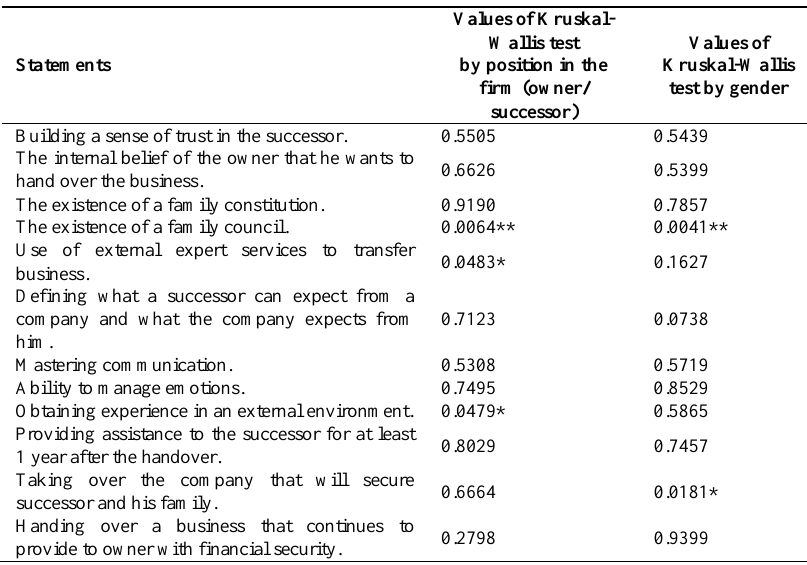
Table 2. Kruskal-Wallis